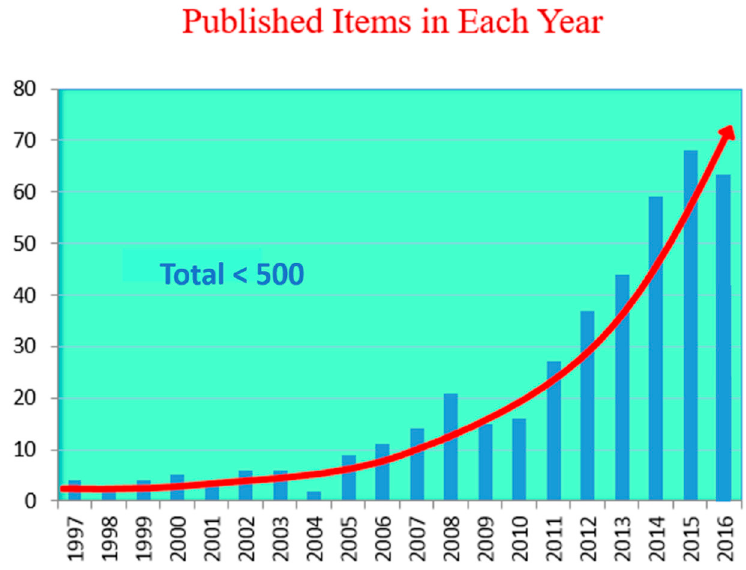
Figure 1. Chronic evolution of number of publications on dilute bismide since 1997.